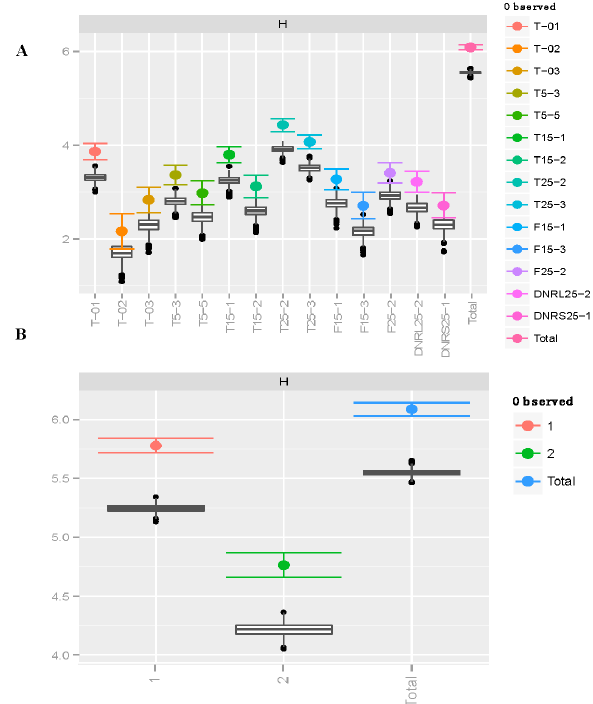
Figure 2. ( A ) Comparisons of P. gaeumannii genotypic diversity by sampling site. N = 10; ( B ) Comparisons of P. gaeumannii genotypic diversity by lineage. 1 = Lineage 1, 2 = Lineage 2. N = 128. H = Shannon-Weiner diversity. The colored dots with error bars represent the observed statistics and their associated 95% confidence intervals. The black and white box and whisker plots represent the values estimated via bootstrapping with 1000 replicates. Table 2. Diversity and heterozygosity of multilocus P. gaeumannii genotypes from two levels of the population hierarchy. ( A ) Diversity and heterozygosity measured for each sampling site ( N = 10 isolates). ( B ) Diversity and heterozygosity values for each lineage ( N = 128